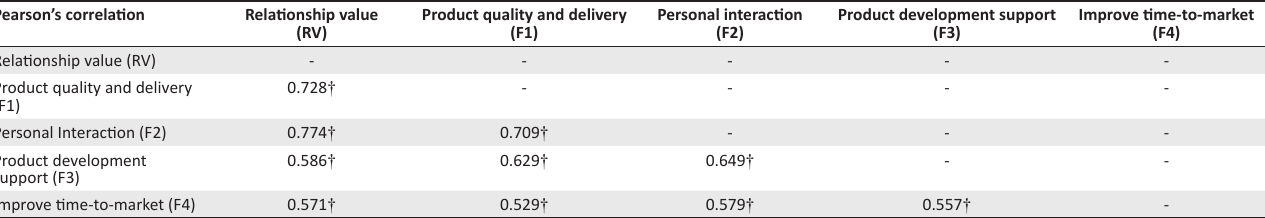
TABLE 2: Pearson’s correlation.